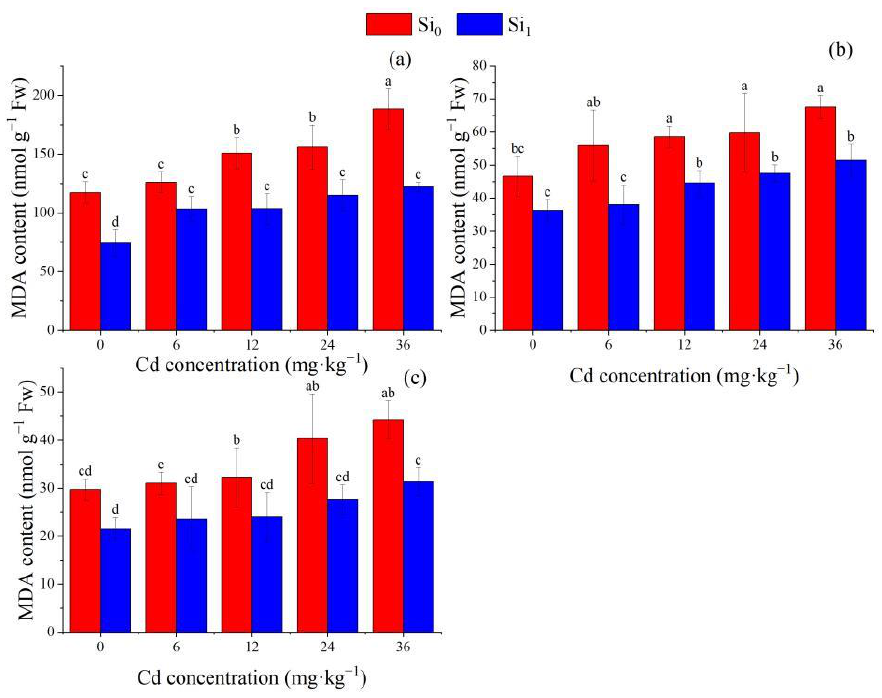
Figure 3. Effects of Cd and Si on MDA contents of seedling for ( a ) Schima superba , ( b ) Chinese sweetgum, and ( c ) Chinese fir. Each value is a mean of six repetitions. Lowercase letters above the bars indicate significant differences according to the Turkey’s test ( p <